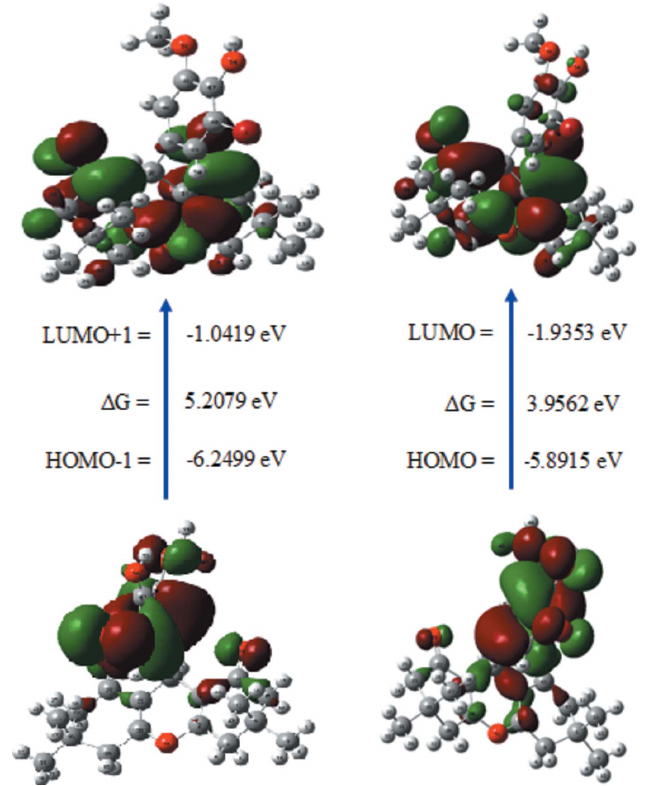
Figure 7 The frontier molecular orbitals of